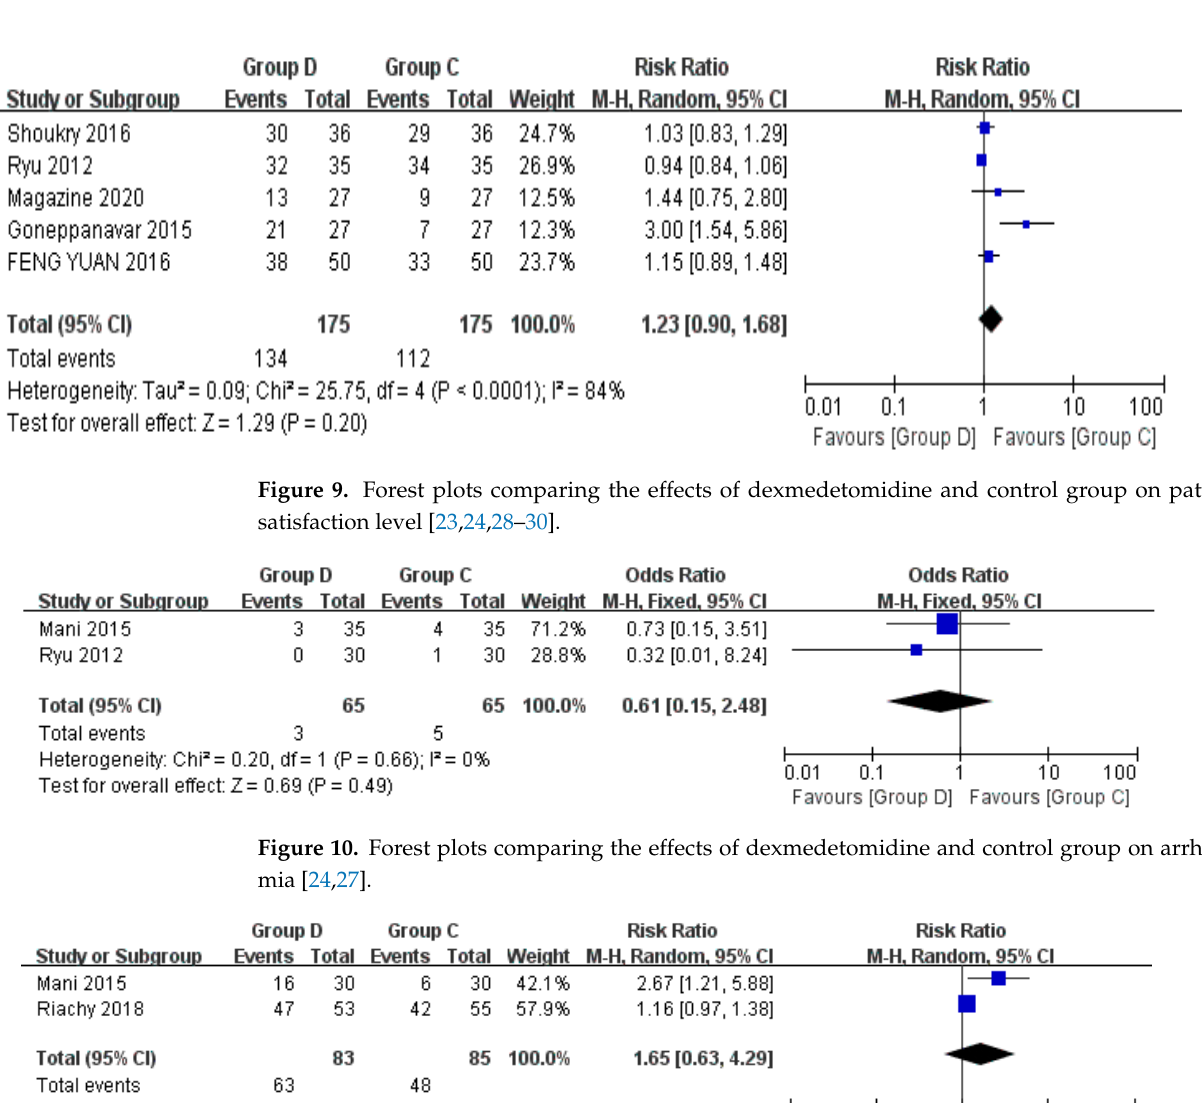
Figure 10. Forest plots comparing the effects of dexmedetomidine and control group on arrhythmia [24,27].